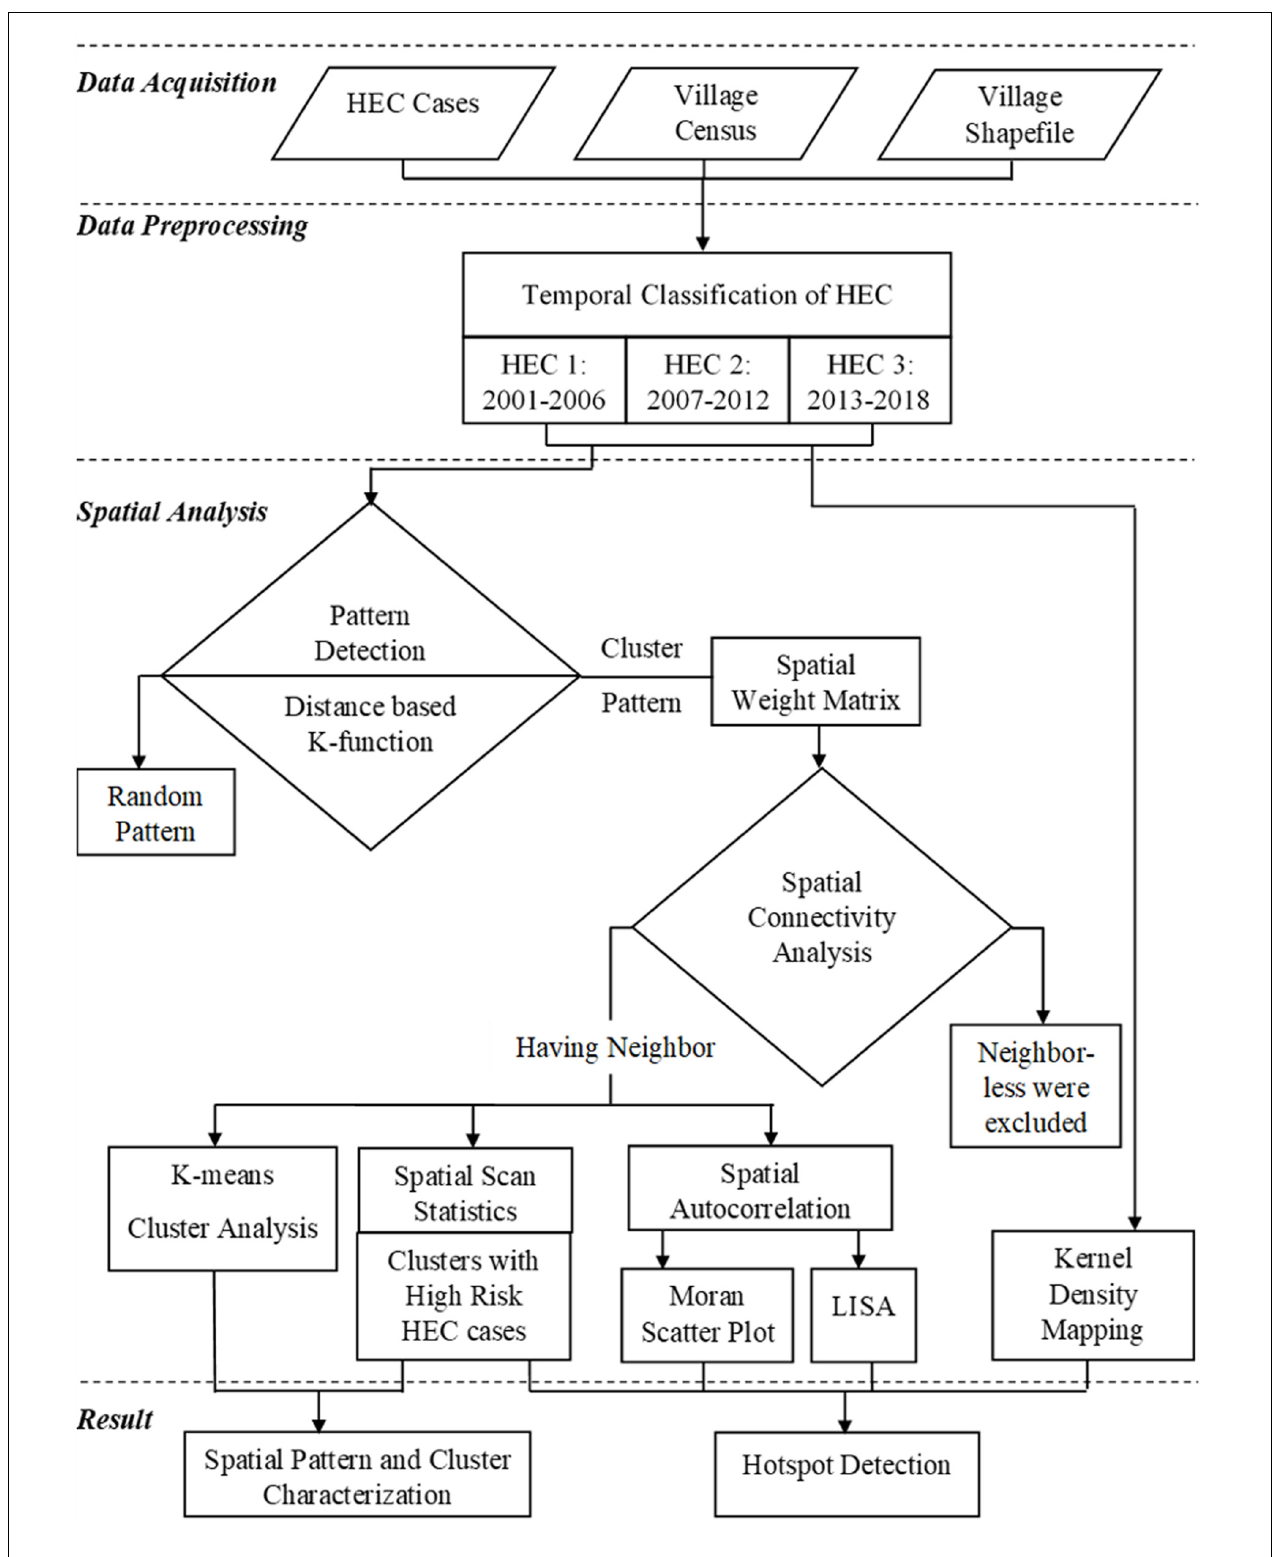
FIGURE 2 | A methodological flowchart for this